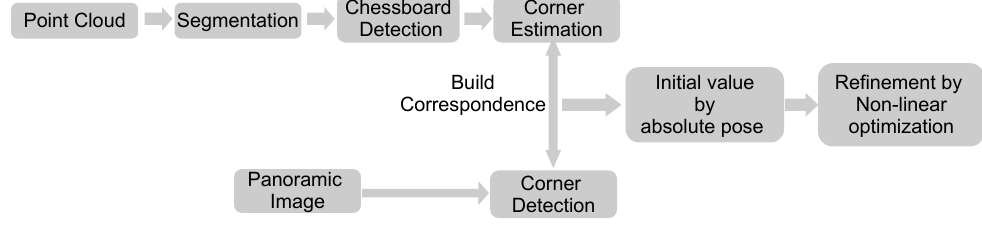
Figure 2. Overview of the proposed